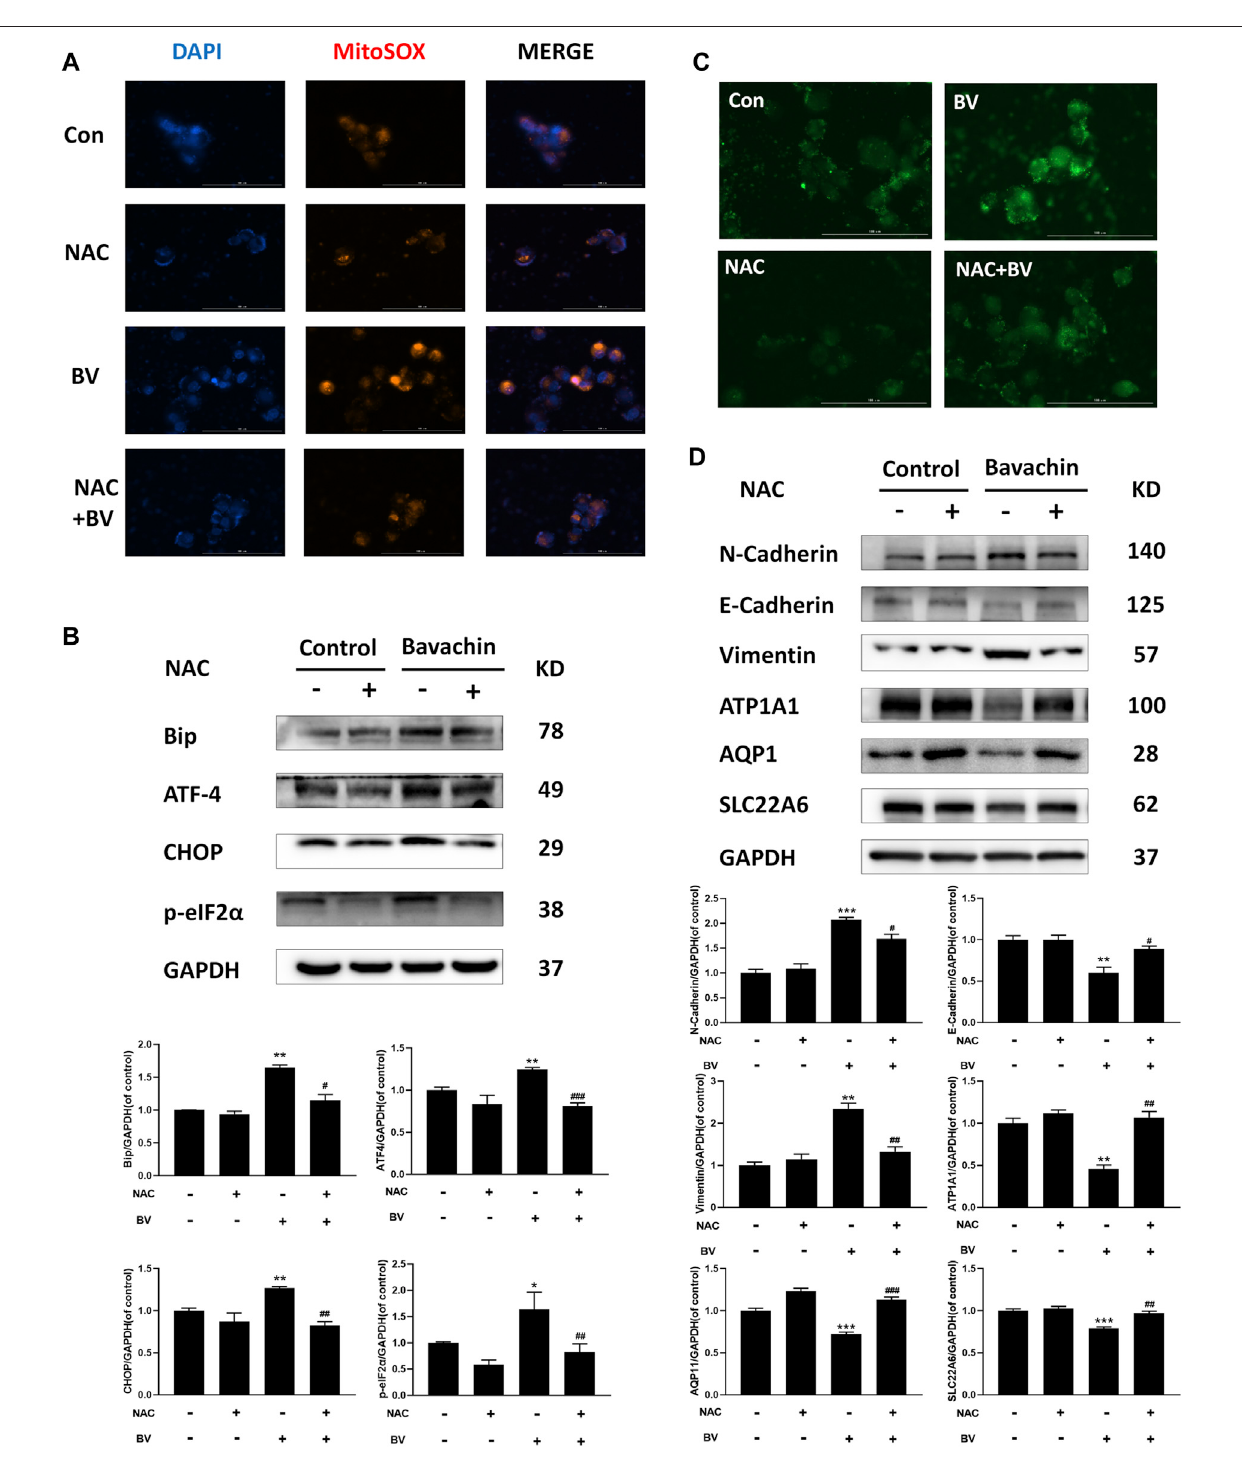
FIGURE 3 | Elevating ROS contributed to BV-triggered ER stress and EMT. (A) Intracellular ROS levels in HK2 cells induced by BV with or without NAC treatment (scale bar: 100 μ m). After NAC treatment, ER stress- (B) , EMT- (D) related proteins, and cellular Ca 2+ concentration (C) were detected with western blot and Fluo 4-AM, respectively. * p < 0.05, ** p < 0.01, and *** p < 0.001 vs. the control groups. # p < 0.05, ## p < 0.01, and ### p < 0.001 vs. the BV-treated groups.